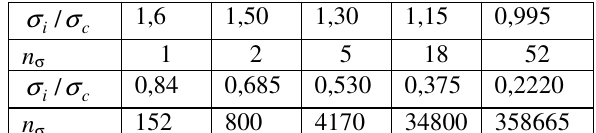
Table 1. Discrete stresses range